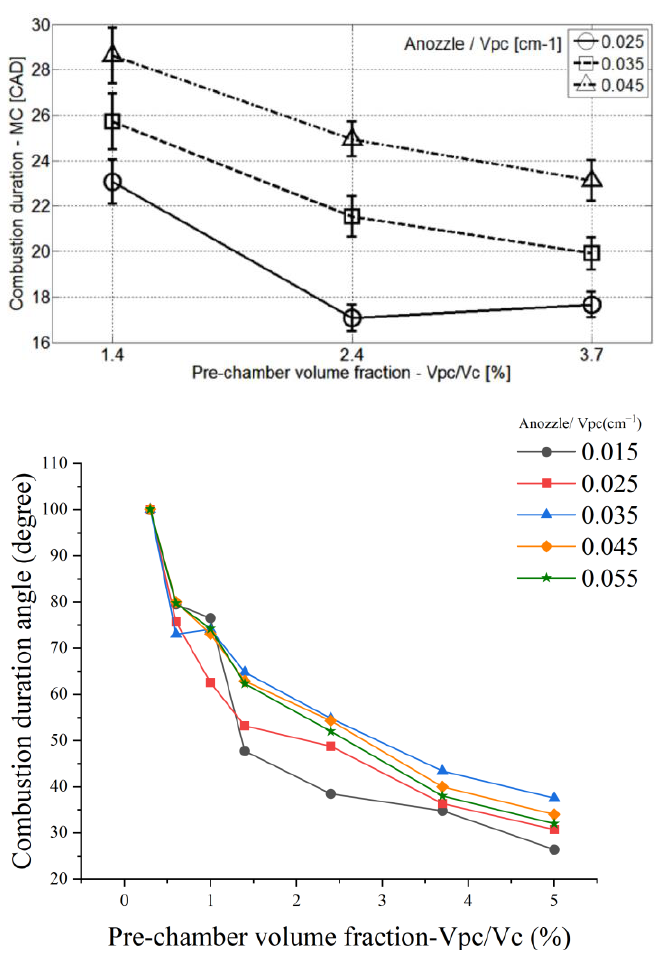
Figure 10. Simulation results of main chamber combustion duration vs. results from Ashish.